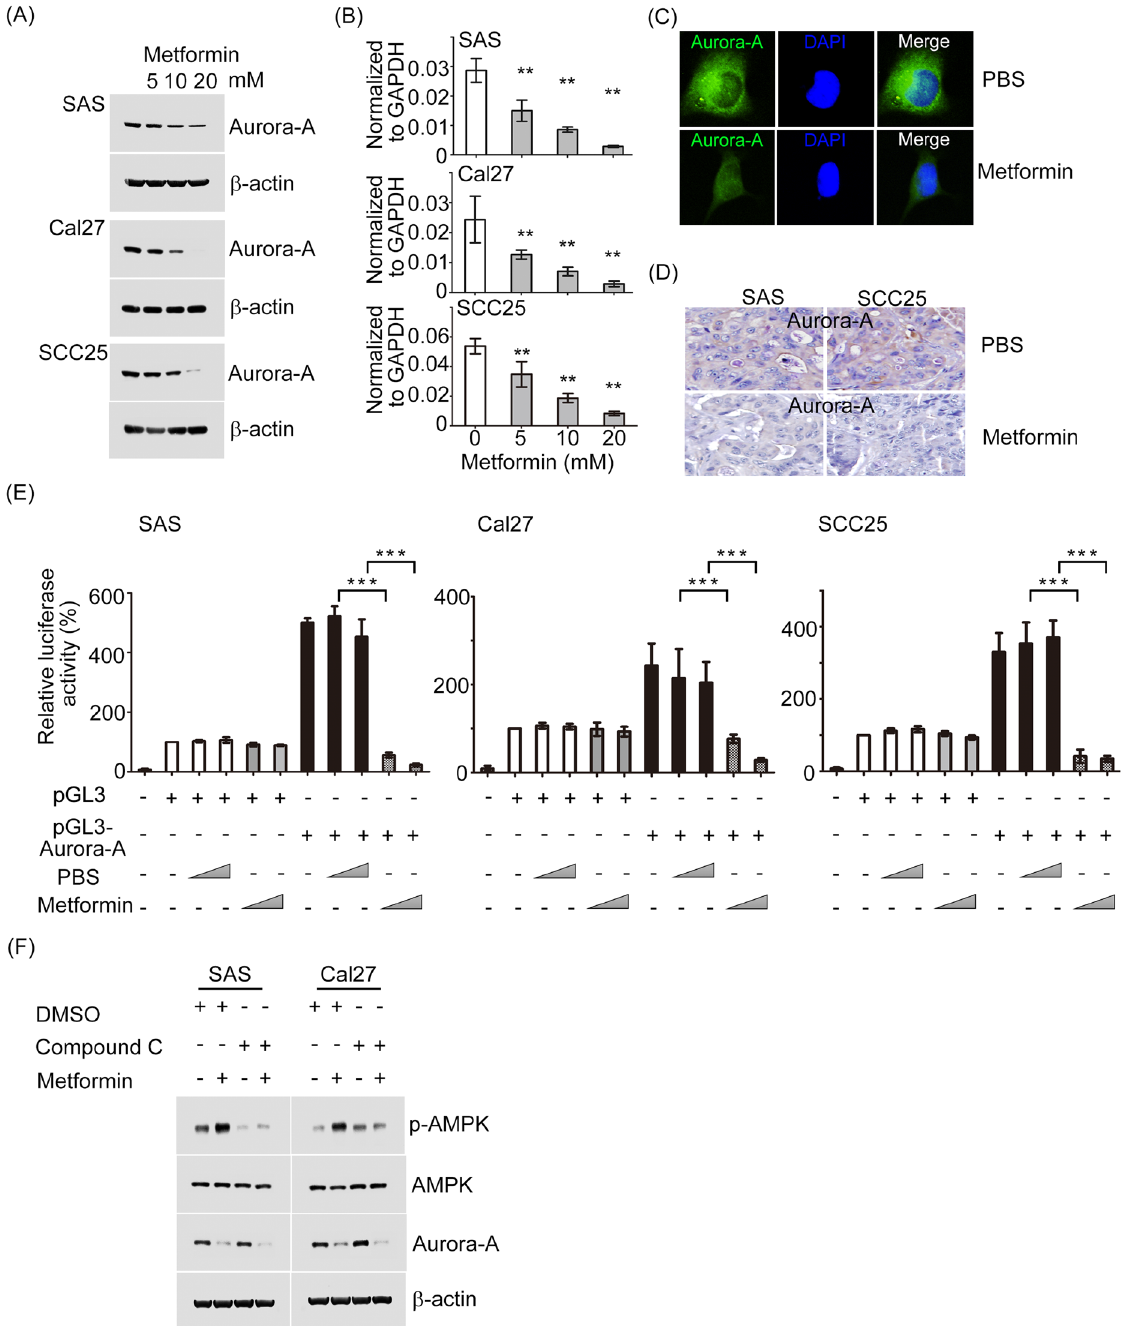
Figure 4. Metformin reduced Aurora-A expression levels in vitro and in vivo . ( A and B ) SAS, Cal27, and SCC25 cells were plated in 6 cm dish and treated with metformin as indicated concentrations or PBS for 48 hour. Following treatment, cells were harvested and the mRNA and protein expression profiles of Aurora-A in each sample were determined using western blot and Q-RT-PCR. ( C ) The expression and distribution of Aurora-A in oral cancer cell lines in the absence or presence of metformin was evaluated by immunofluorescence microscopy. ( D ) Representative images of immunohistochemistry of Aurora-A. ( E ) Relative luciferase activity is shown for reporter constructs containing Aurora-A promoter region. pGL3 or pGL3-Aurora-A promoter was co-transfected with 200 ng of internal control plasmid expressing Renilla-luciferase into the oral cancer cell lines. After 24 hour, cells were treated with in the absence or present of metformin in a dose-dependent manner. Relative luciferase activities were measured at 48 h after treatment. The relative luciferase activity was determined after normalizing to Renilla-luciferase activity. ( F ) SAS and Cal27 cells were pretreated for 1 h with 5 μ M compound C (AMPK inhibitor) and then the cells were treated for an additional 24 h with 5 mM metformin. Phosphorylated AMPK, total AMPK, and Aurora-A protein expressions were assessed by Western blotting. All values represent the mean ± SD of three independent transfections. ( ** p < 0.01; *** p <